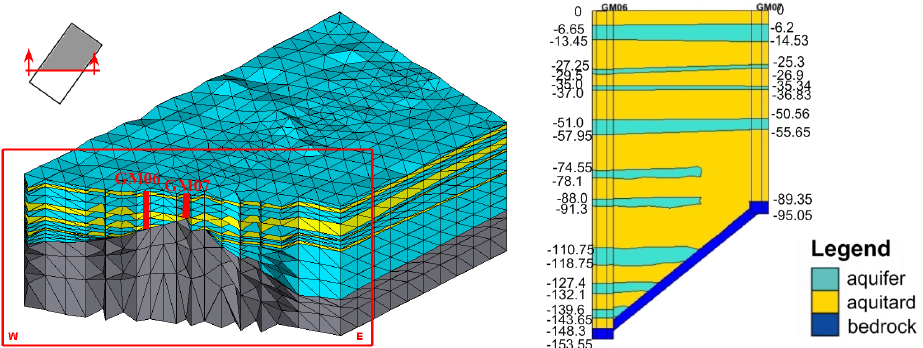
Figure 6. Perspective view of the Finite-Element model developed by Franceschini et al. (2015) to simulate the earth fissure generation at Guangming Village (a) . The geological setting is highlighted in various colours: rock in grey, aquifers in yellow, and aquitards in blue). Hydrogeological profile between boreholes GM06 and GM07 (b) . The numbers provide the buried depths of the top of each